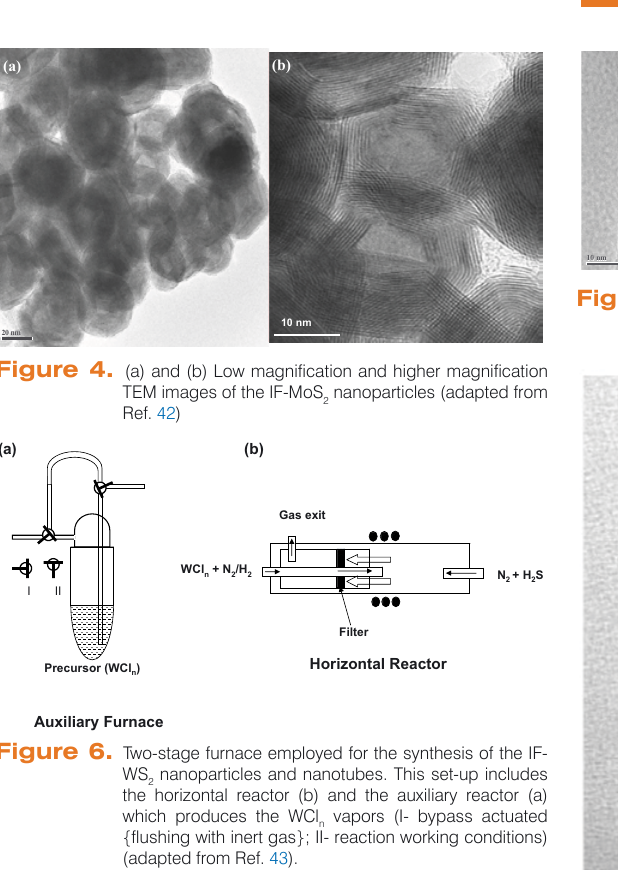
nanoparticle 2 Cl with H S in the hori- 2 2 2